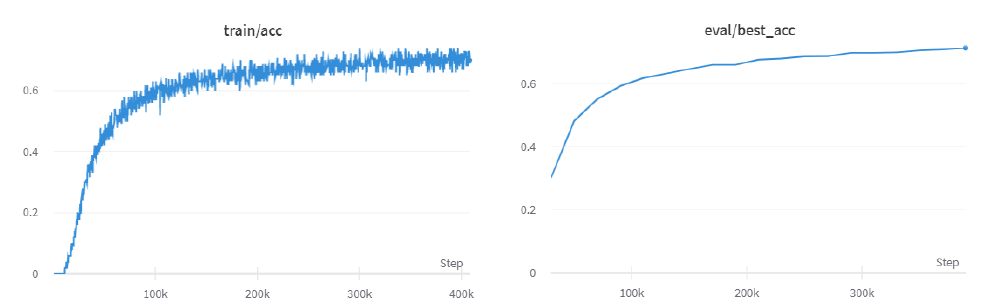
Figure 8. Best training and evaluation accuracy in ‘Experiment 4’.